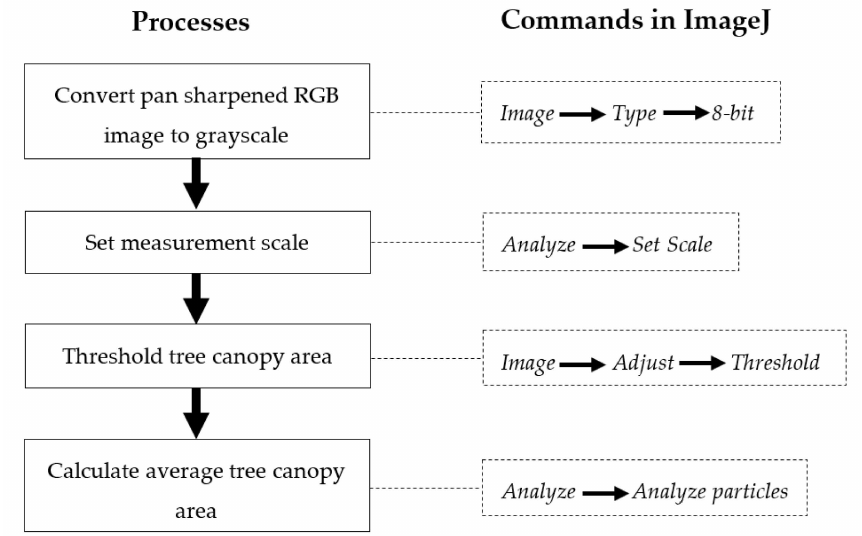
Figure 3. The flowchart of TCA extraction process in ImageJ. Processes are shown in left and the commands in ImageJ software are shown in